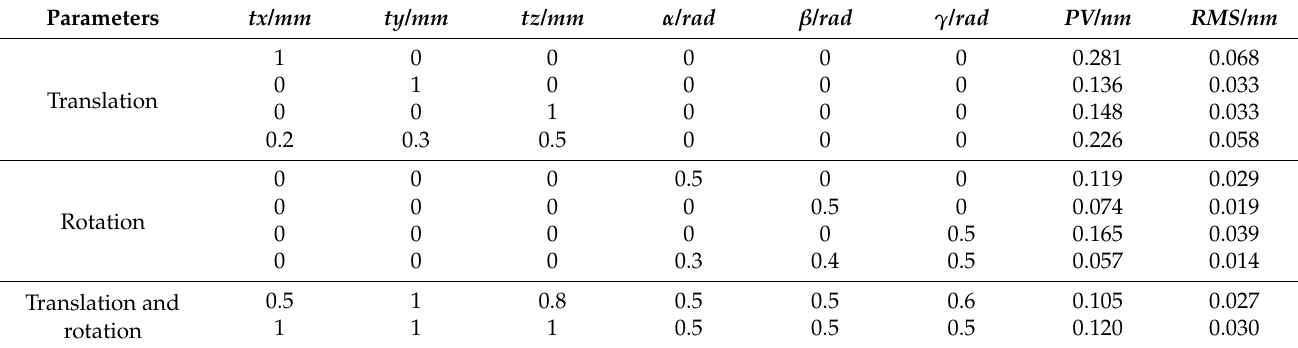
Table 2. Simulation results of form error with different coordinate transfer matrix T 1